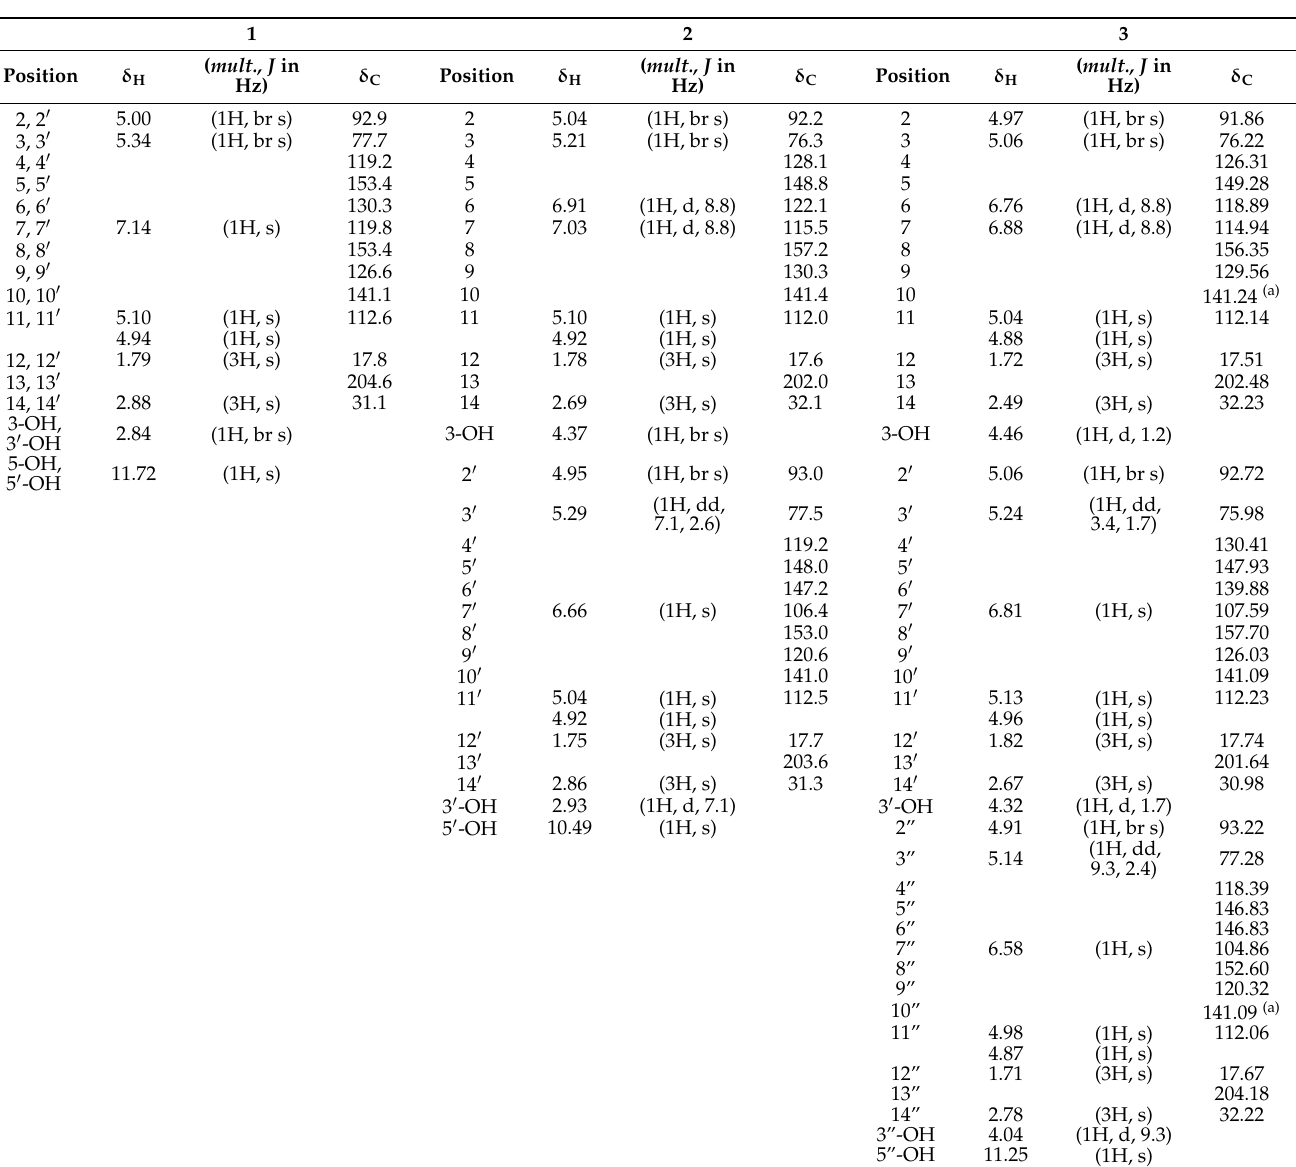
Table 1. 1 H (500 MHz) and 13 C (126 MHz) NMR data of 1 – 3 in CDCl 3